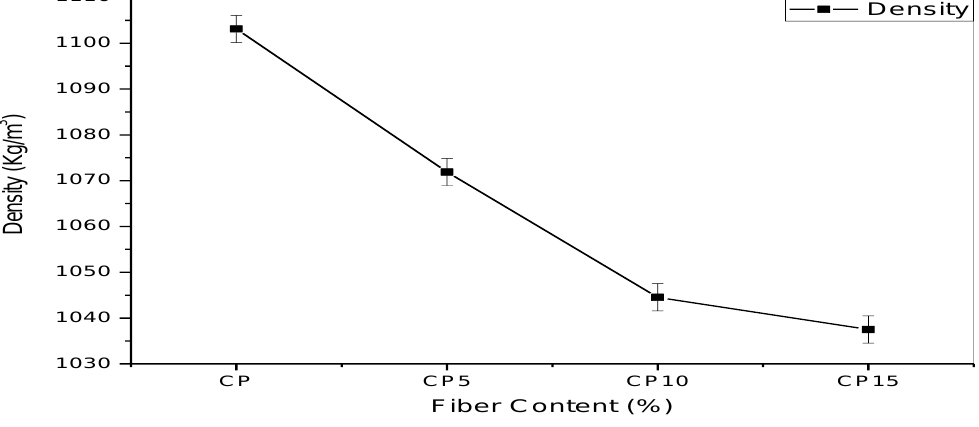
Figure 11. Density variation versus wheat straw of composites.